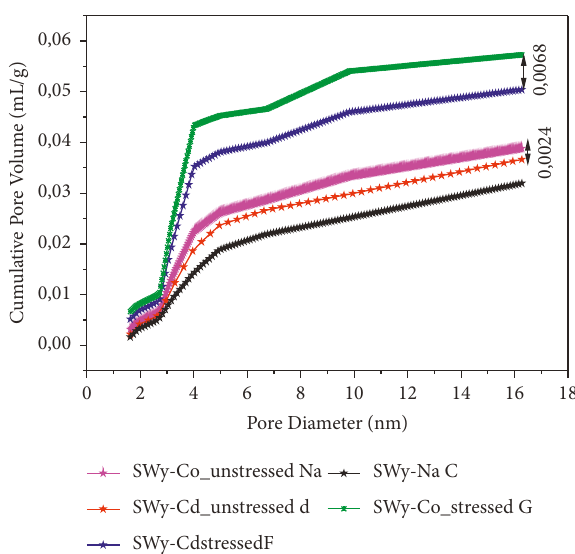
Figure 9: The pore size distribution (PSD) curve for the different studied samples (V-r).